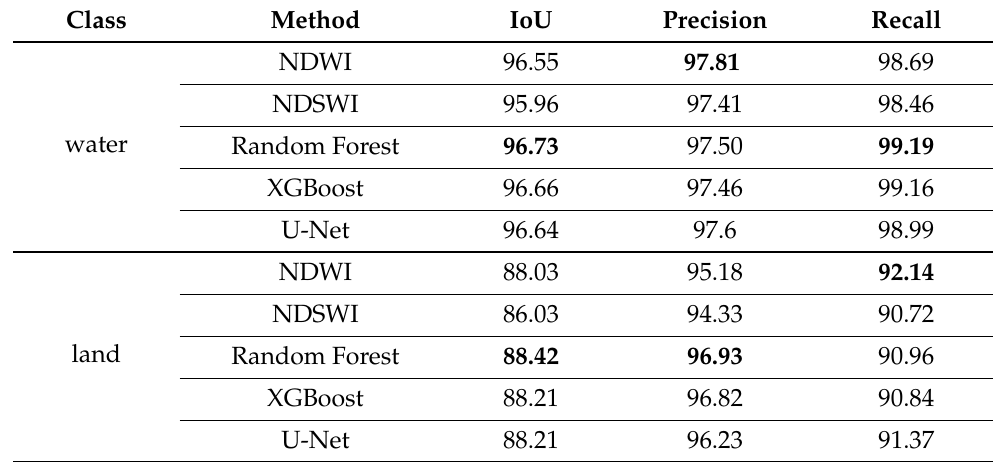
Table 3. Experimental results for coastal subregions using different methods. The overall performance of all the models are better for coastal